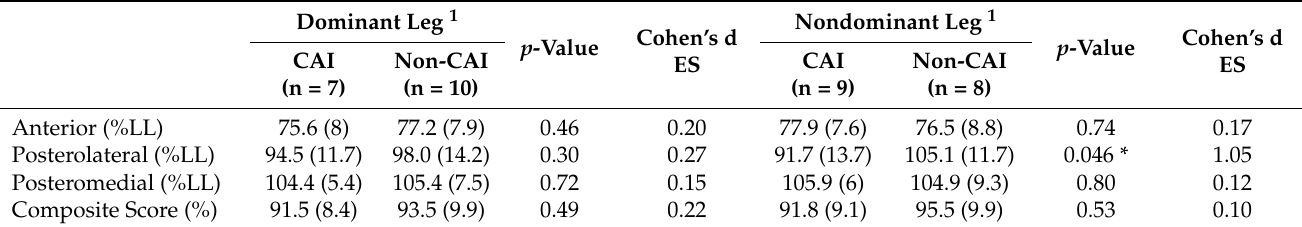
Table 3. mSEBT of the dominant and the nondominant legs in the CAI and non-CAI groups.